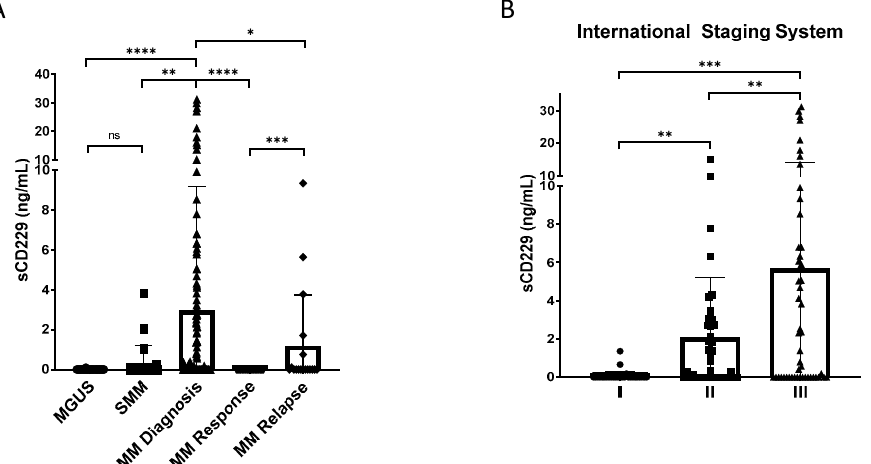
Figure 7. Serum sCD229 levels in patients with MM. ( A ) sCD229 levels in serum samples from 54 patients with MGUS, 23 patients with SMM, 122 patients with newly diagnosed MM, 39 patients achieving response, and 18 patients after myeloma relapse. ( B ) sCD229 levels in serum samples from 122 patients with NDMM according to the International Staging System (ISS). ns, non ‐ significant; * p < 0.05; ** p < 0.01; *** p < 0.001; **** p < 0.0001.